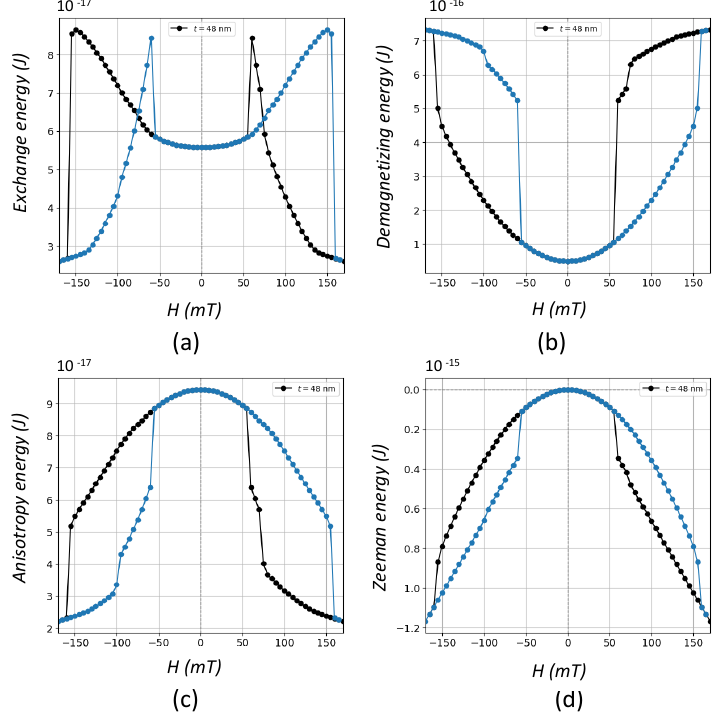
Figure 4. Energy cycles for a prism with L = 300 nm and t = 48 nm for ( a ) Exchange energy, ( b ) Demagnetizing energy, ( c ) Anisotropy energy and ( d ) Zeeman energy. Two colors are used to differentiate the branches corresponding to the decreasing field branch (black circles) and the increasing field branch (blue circles).